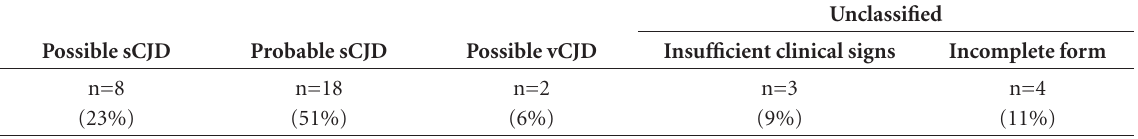
Table 1. Classification of notified patients according to WHO criteria for human prion diseases.